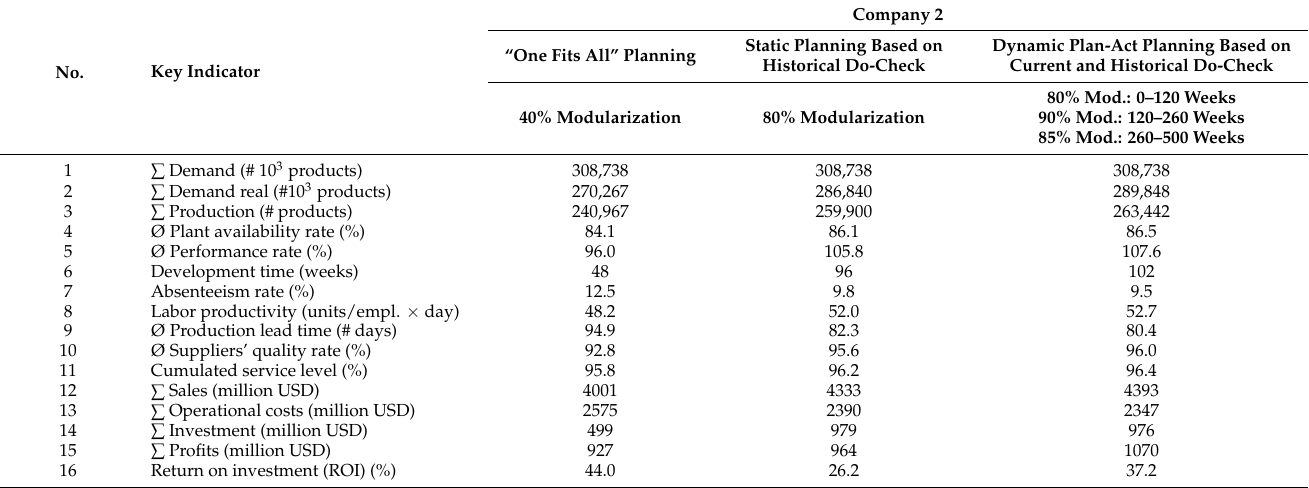
Table 2. Simulation results for the Innovation Case Study: Product Modularization in Company 2.